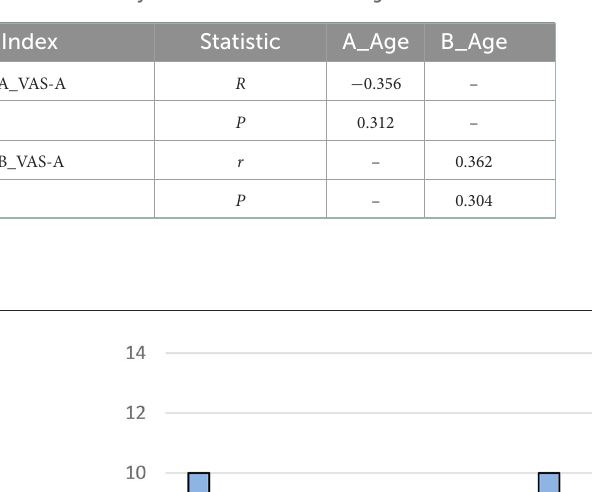
TABLE 10 The analysis of correlation between age and VAS-A.